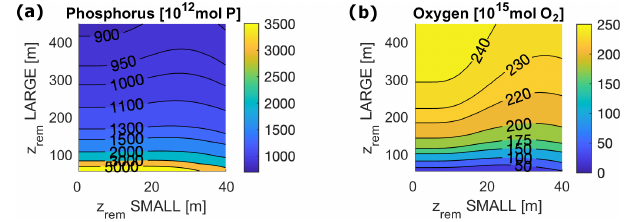
Figure 4. Total ocean budgets of (a) P and (b) O at equilibrium for varying z remS and z remL .